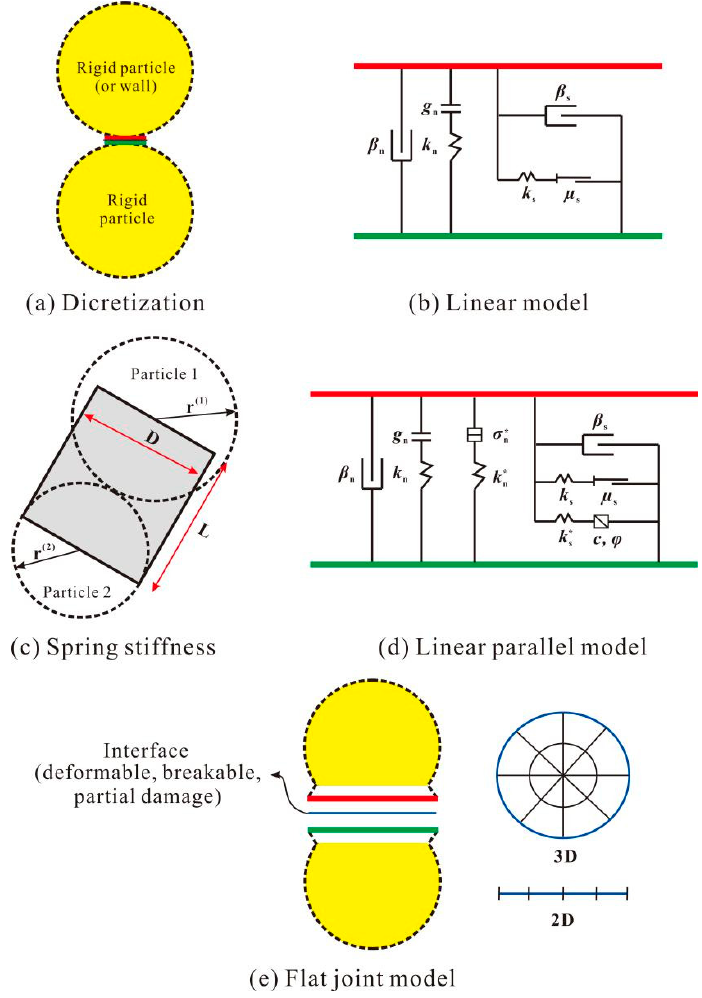
Figure 4. The PFC2D software’s constitutive models.